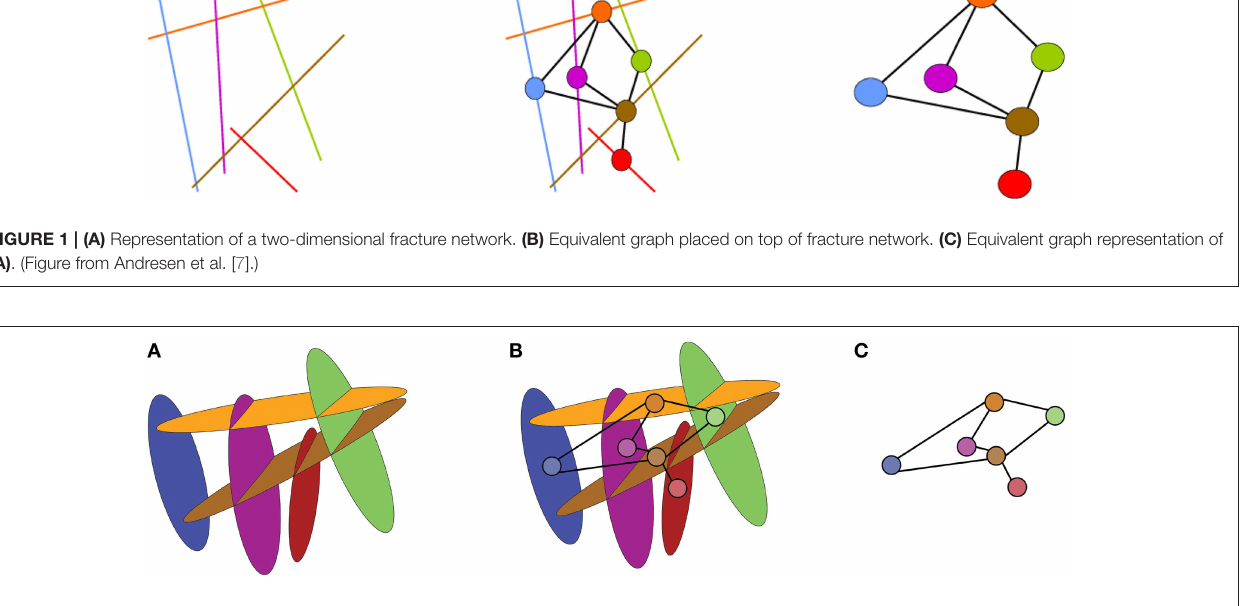
FIGURE 2 | (A) Representation of a three-dimensional fracture network. (B) Equivalent graph placed on top of fracture network. (C) Equivalent graph representation of (A) .